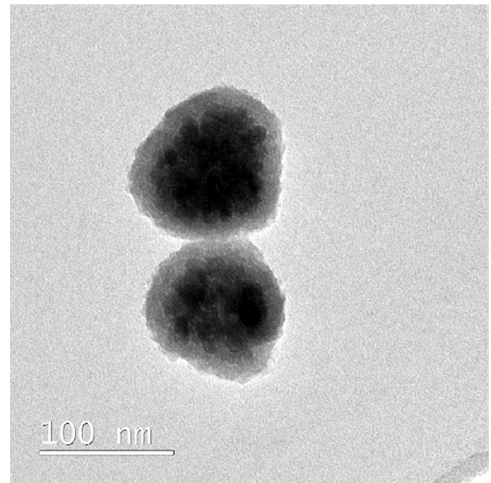
Figure 5. Transmission electron microscopy micrograph of the synthesis methods used on Fe 3 O 4 @SiO 2 @MIP.